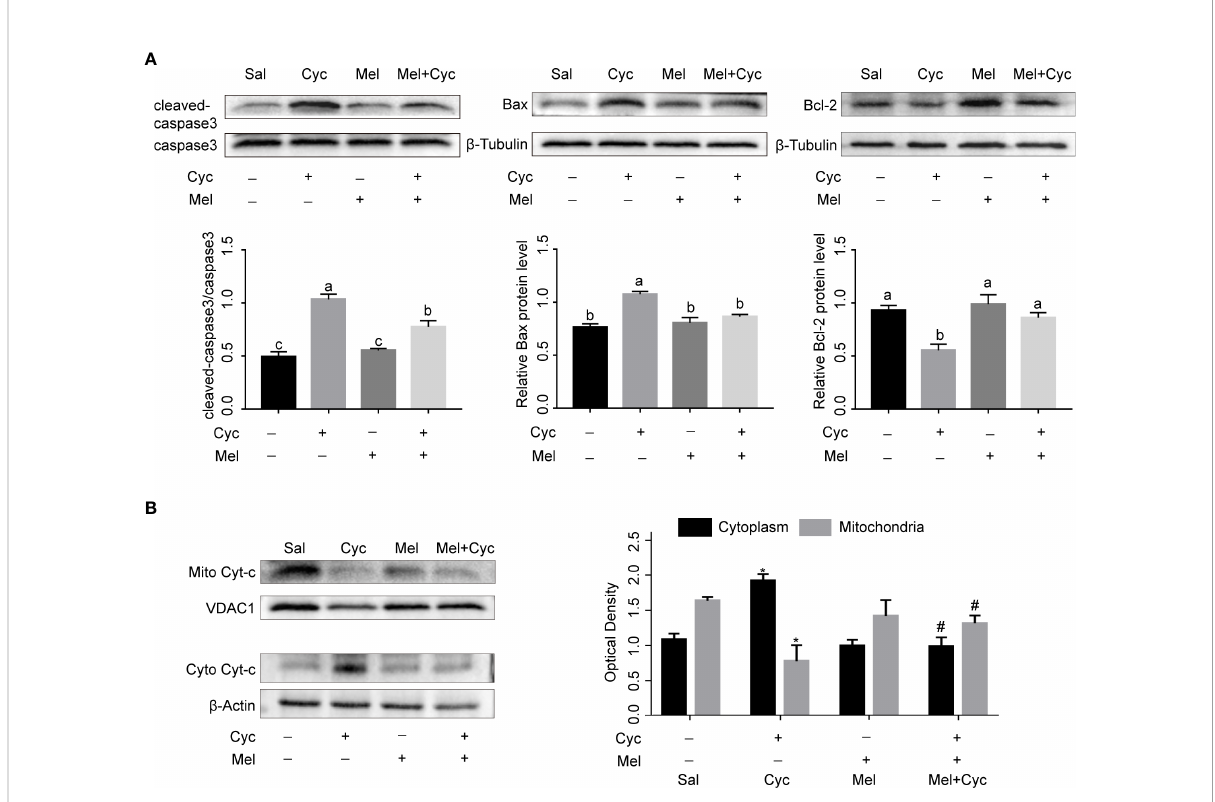
FIGURE 5 Mel inhibits Cyc-induced apoptosis of granulosa cells through mitochondrial apoptosis pathway. (A) Western blot analysis was performed on cleaved-caspase3, caspase3, Bax, and Bcl-2 in the ovaries of three-week-old ICR mice 12 h after Cyc (75 mg/kg) treatment with or without Mel (n = 6). a,b,c Bars with different letters are signi fi cantly different in each group ( P < 0.05 ). (B) Western blot analysis was performed on mitochondrial Cyt-c (mito Cyt-c) and cytoplasm Cyt-c (cyto Cyt-c) in the ovaries of three-week-old ICR mice 12 h after Cyc (75 mg/kg) treatment with or without Mel (n = 6). * P < 0.05 compared with Sal group. # P < 0.05 compared with Cyc